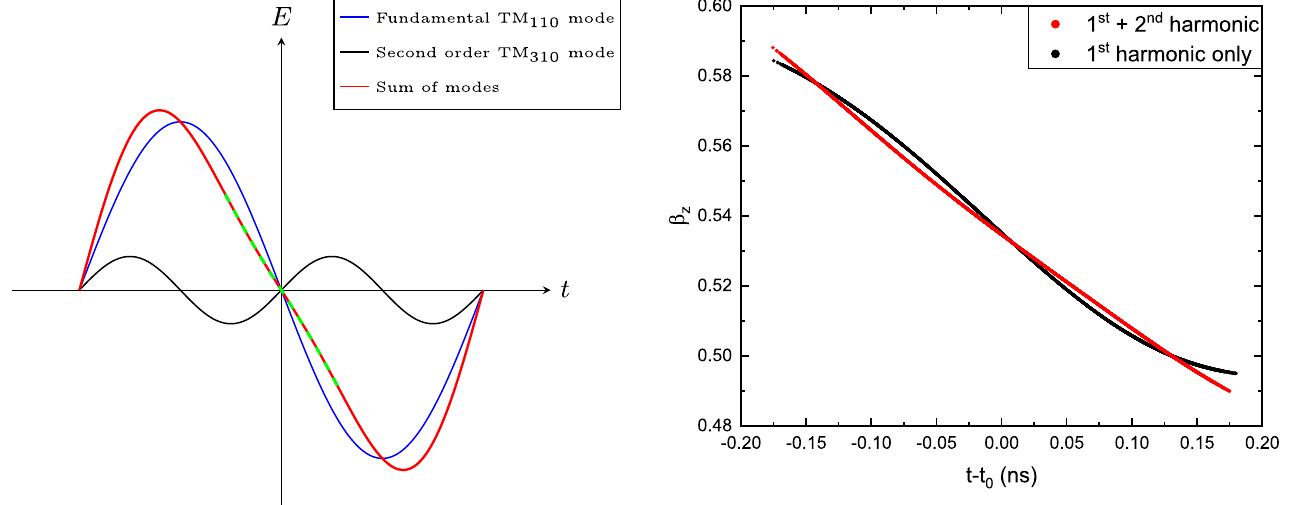
FIG. 7. The time-dependent electric field in the center of the compression cavity. The dashed green line represents the field probed by an electron bunch.